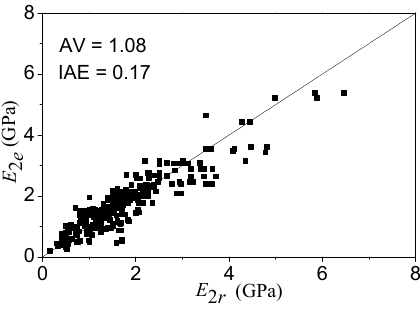
Figure 9. The performance of the E 2 model.